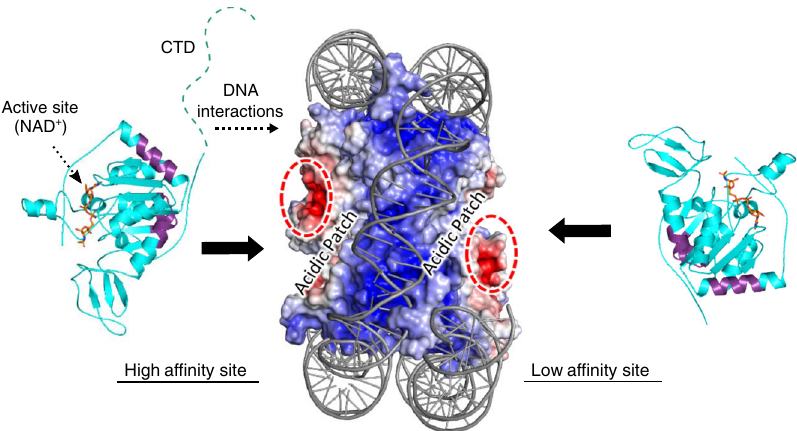
Fig. 6 Multivalent interactions comprise the SIRT6:nucleosome interaction. The nucleosome core particle is shown in surface representation and the SIRT6 structure (residues 13 – 296) is in cartoon. Under the simplest model, each acidic patch on either side of the nucleosome supports binding to one SIRT6 molecule, depicted here with purple residues representing the most protected peptides in HDX analysis (Fig. 2c). The CTD is necessary for interactions with nucleosomal DNA at the higher af fi